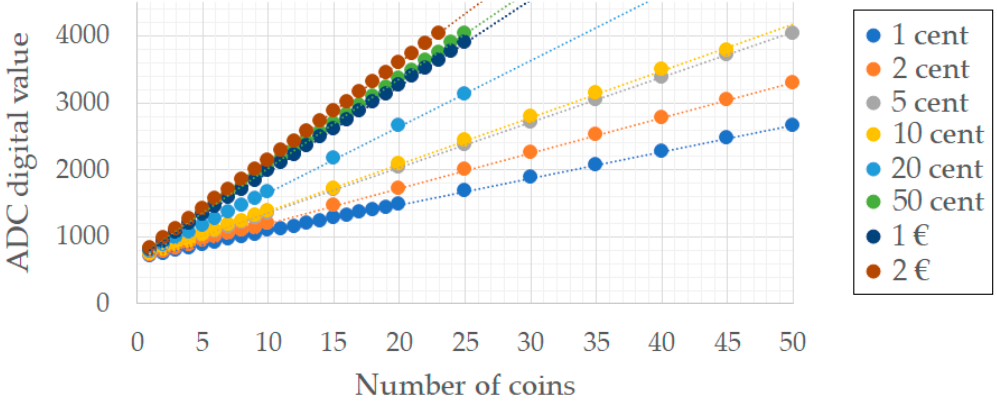
Figure 16. Graphical representation of the analog-to-digital conversion performed by the AD module (12-bit